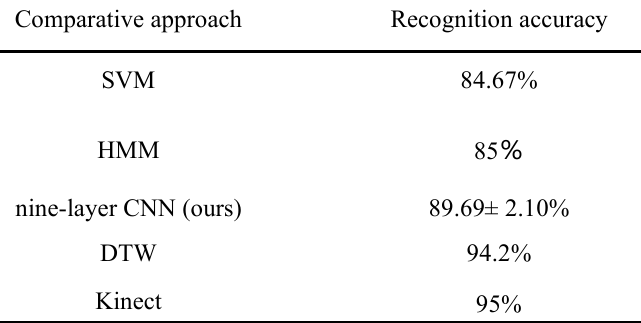
Table 4. Comparison of SVM, HMM, DTW,